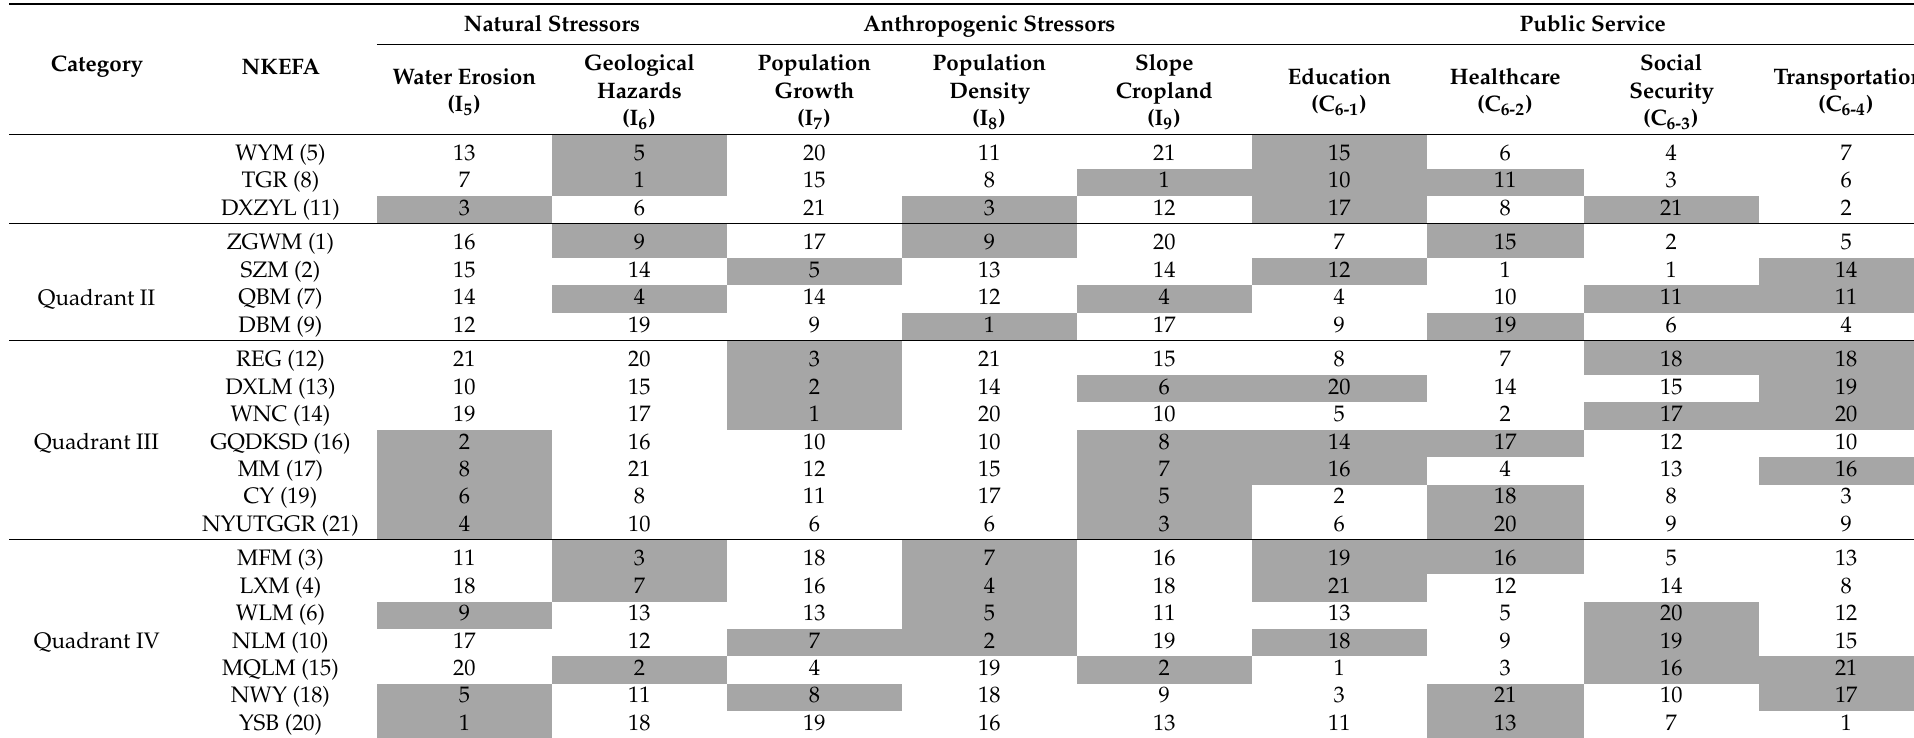
The grey fields are identified as main stressors or public service weaknesses in each